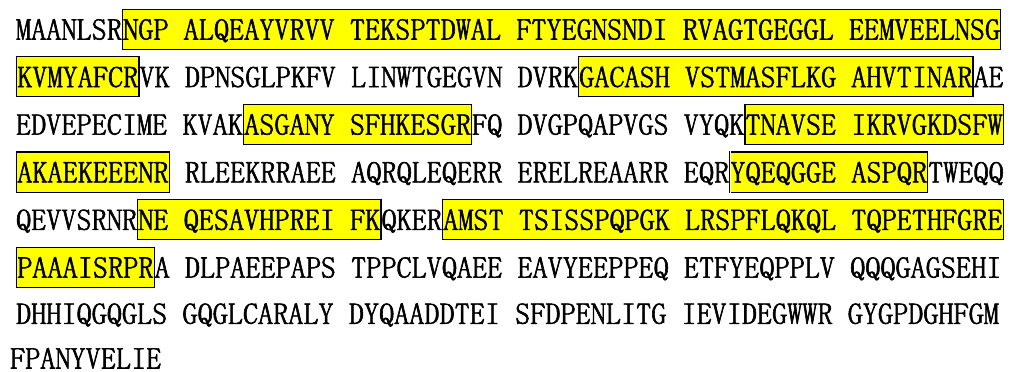
Figure 2. Primary structure of HIP-55 protein. The tryptic peptides identified by LC-MS/MS analysis are highlighted. MAANLSRNGP ALQEAYVRVV TEKSPTDWAL FTYEGNSNDI RVAGTGEGGL EEMVEELNSG KVMYAFCRVK DPNSGLPKFV LINWTGEGVN DVRKGACASH VSTMASFLKG AHVTINARAE EDVEPECIME KVAKASGANY SFHKESGRFQ DVGPQAPVGS VYQKTNAVSE IKRVGKDSFW AKAEKEEENR RLEEKRRAEE AQRQLEQERR ERELREAARR EQRYQEQGGE ASPQRTWEQQ QEVVSRNRNE QESAVHPREI FKQKERAMST TSISSPQPGK LRSPFLQKQL TQPETHFGRE PAAAISRPRA DLPAEEPAPS TPPCLVQAEE EAVYEEPPEQ ETFYEQPPLV QQQGAGSEHI DHHIQGQGLS GQGLCARALY DYQAADDTEI SFDPENLITG IEVIDEGWWR GYGPDGHFGM